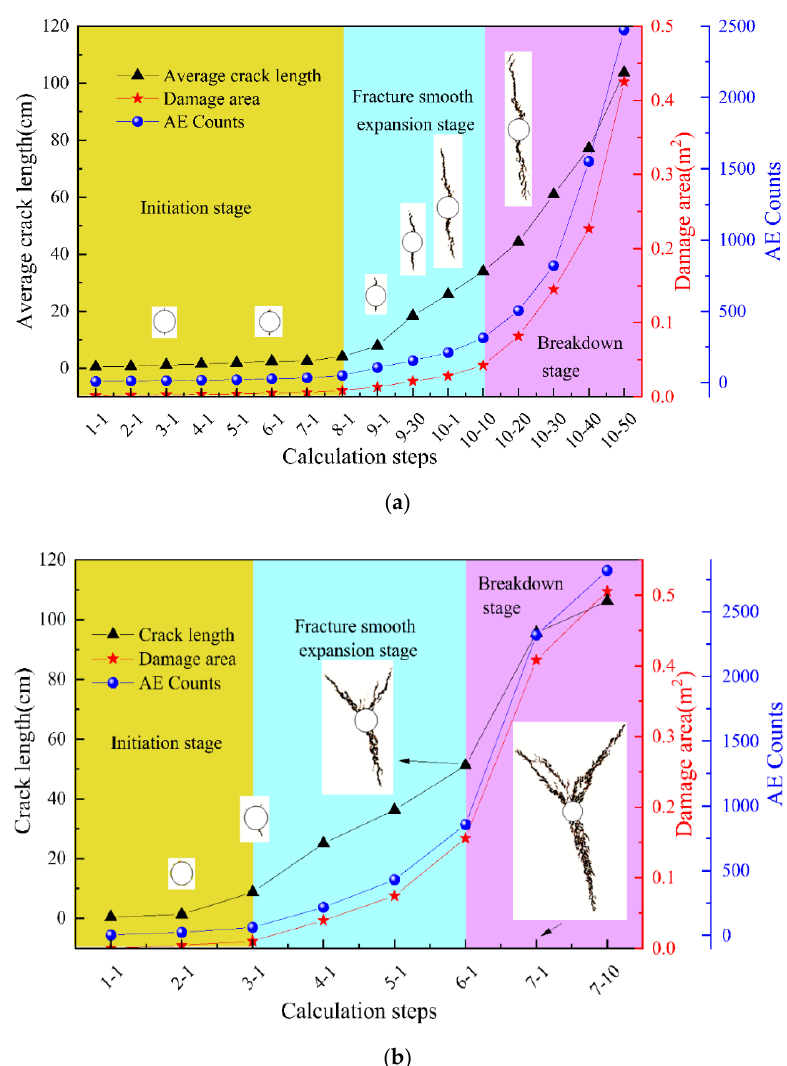
Figure 9. Cumulative crack length, damage zone area and cumulative AE counts of fracturing hole change with calculation time step at different hydraulic fracturing stages: ( a ) ξ = 0.5; ( b ) ξ = 1.0. In addition, regardless of the lateral pressure coefficients, the AE parameters at the fracture stage increase rapidly, accompanied by a large number of unit damages. Further- more, the fracture pressure is 8.25 MPa for ξ = 0.5 and 17.05 MPa for ξ = 1. The above